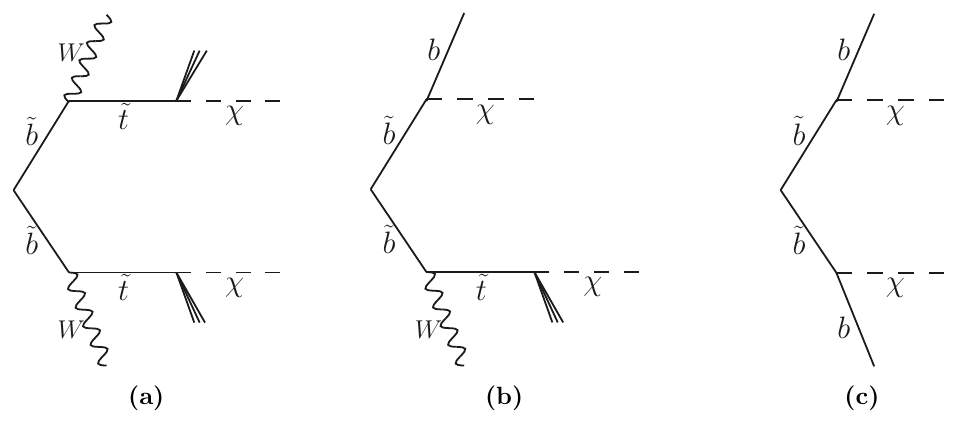
Figure 2 . Three ways for a sbottom pair to decay for the scenario studied in this paper: (a) symmetric decay of ~ b ! ~ t W , (b) asymmetric decay, and (c) symmetric decay of ~ b ! b (cid:31)